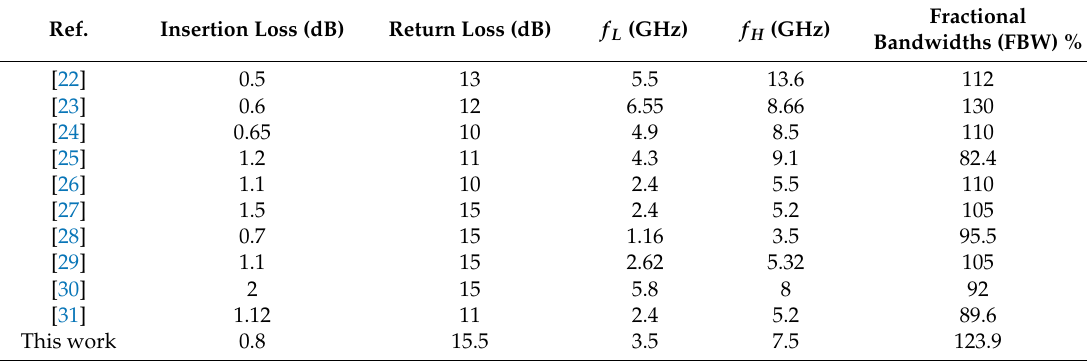
Table 5. Comparison of the proposed filter with recently proposed ultra-wideband bandpass filters with notched